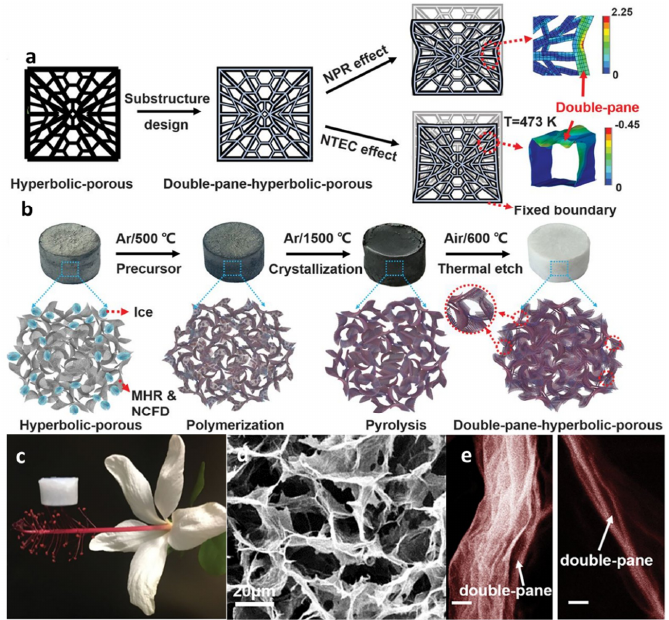
Figure 12. Structure design and fabrication of the ceramic aerogel metamaterial. ( a ) Illustration of the metastructure design of ceramic aerogels. The units of the colored scale bars are as follows: kilopascals for NPR and percentage (with strain zoomed by 30 times) for NTEC. ( b ) Illustration of the CVD synthesis process of the double‐paned hyperbolic ceramicaerogels. ( c ) An optical image showing an h‐BNAG sample resting on the stamen of a flower. ( d ) SEM image of h‐BNAG. ( e ) SEM images of the double‐pane wall structure of h‐BNAGs. Scale bars, 20 nm. Adapted from [138] with permission, copyright the American Association for the Advancement of Science, 2019.